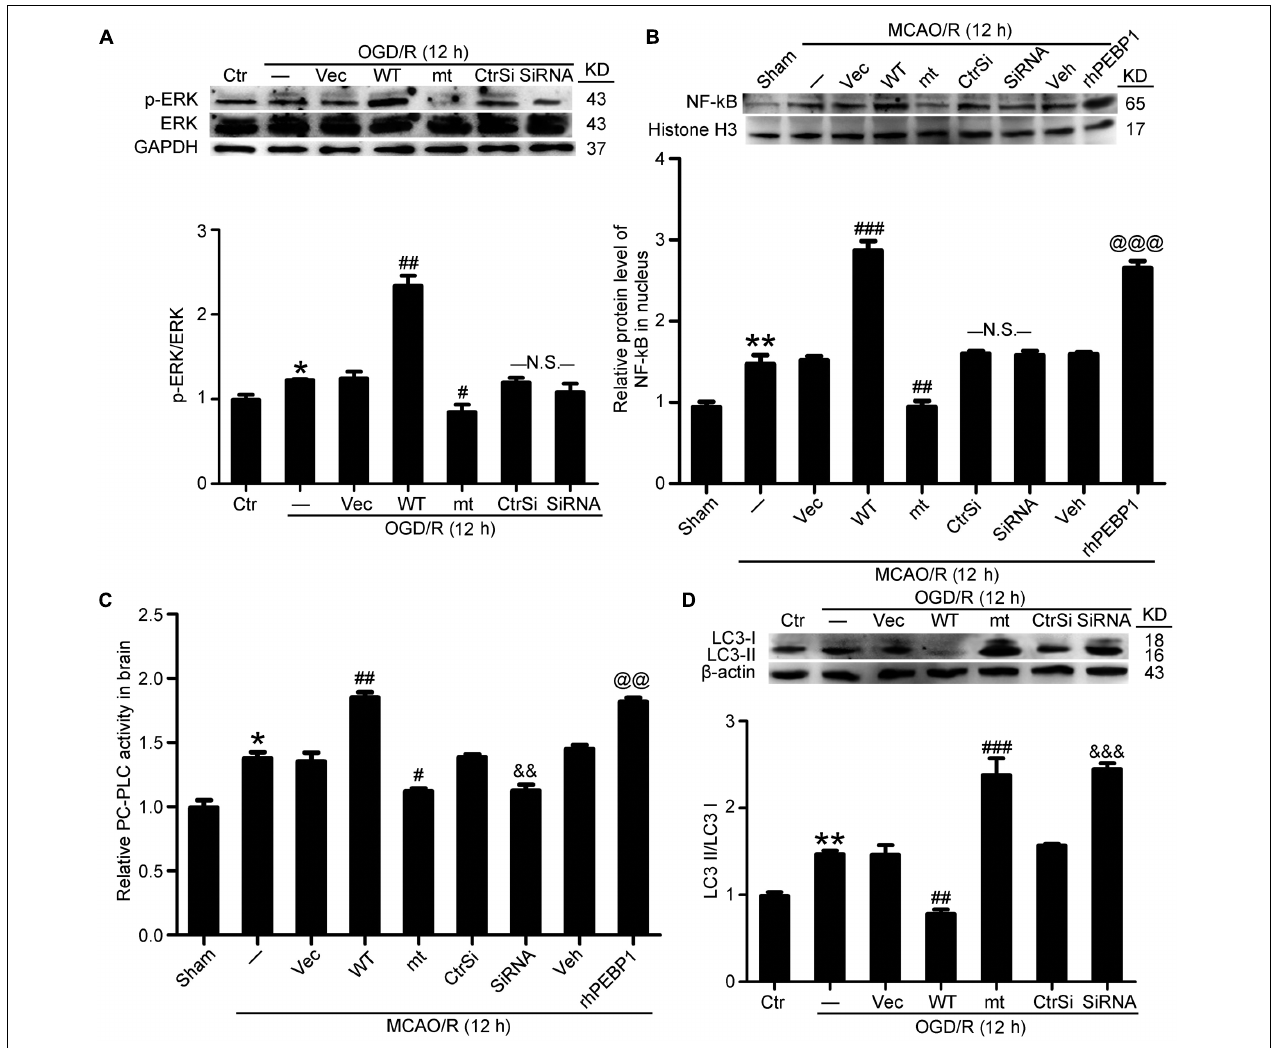
FIGURE 7 | Effects of PEBP1 overexpression and knockdown and rhPEBP1 treatment on ERK/NF- κ B signaling pathway, PC-PLC activity and autophagy after I/R at indicated times. (A) Western blot analysis and quantification of the level of p-ERK and ERK in cultured neurons exposed to OGD/R for 12 h. ∗ p = 0.076 vs. control group, ## p = 0.0033 vs. OGD/R + vector group, # p = 0.046 vs. OGD/R + vector group, N.S. = no significant ( n = 6). (B) Western blot analysis and quantification of the level of NF- κ B in nuclear protein of penumbra tissue at 12 h after MCAO/R. ∗∗ p = 0.0056 vs. sham group, ### p < 0.001 vs. MCAO/R + vector